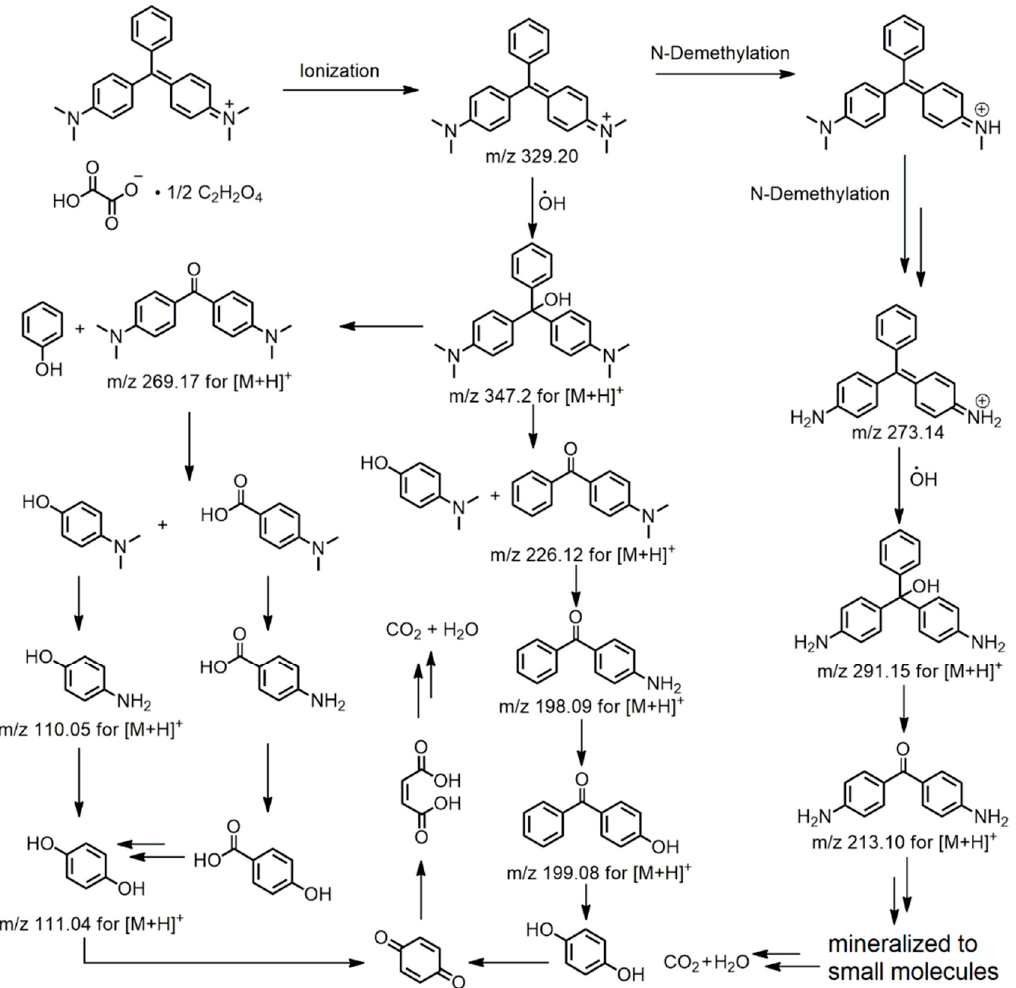
Figure 10. Possible intermediates of the reaction between MG and the photocatalyst under visible light irradiation in aqueous solution.